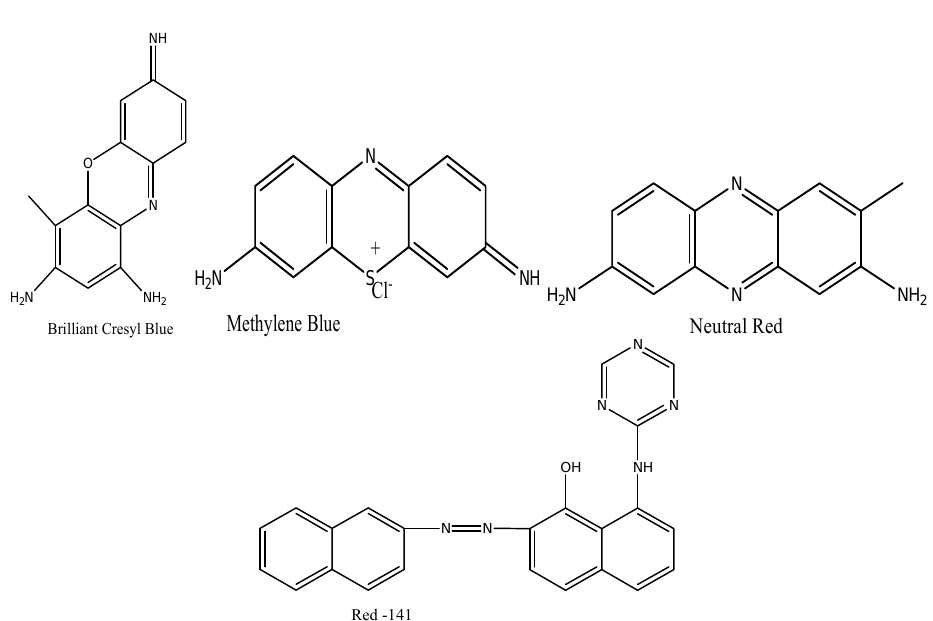
Figure 1. Chemical structures of the seven dyes used in this